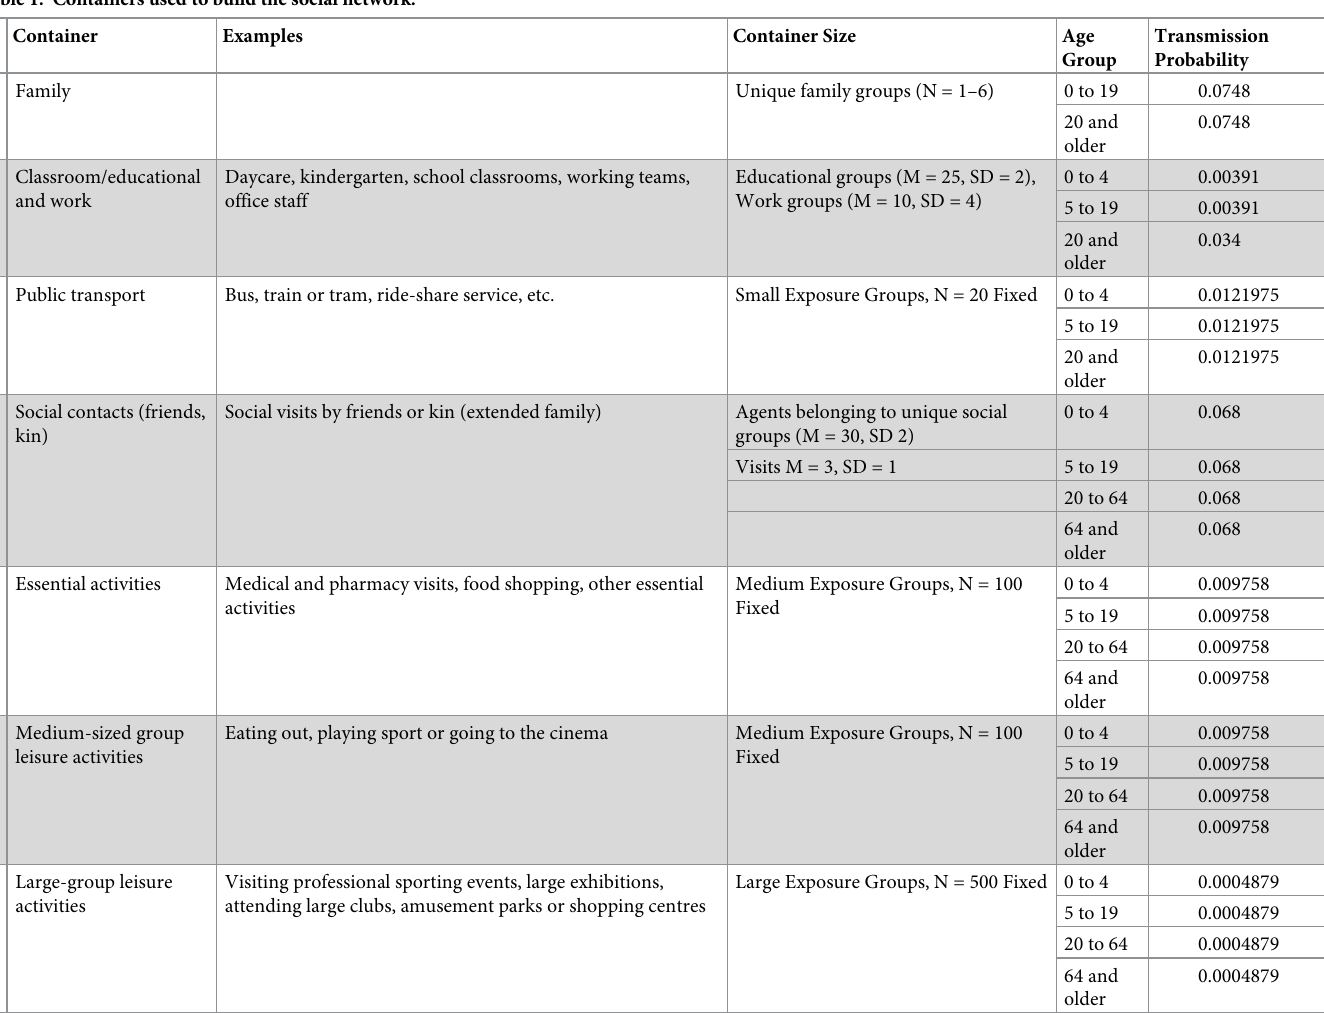
Table 1. Containers used to build the social